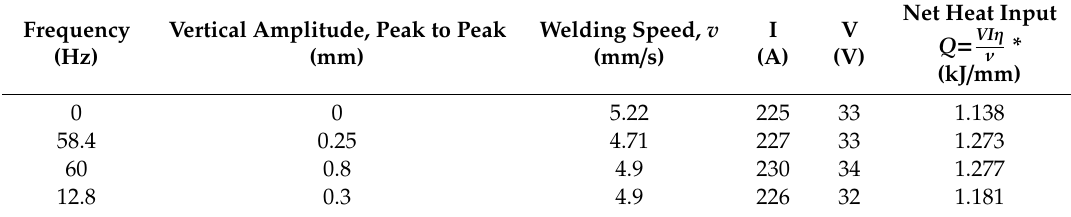
Figure 3. Vibration mode analysis. ( a ) Frequency analysis, 1 st mode, qualitative deformation map. ( b ) table plate, simulating elastomer pads at the four corners. Table 1. Summary of welding parameters.